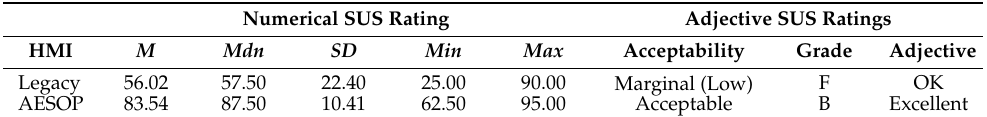
Figure 6. Boxplot of SUS Score Distributions for both HMIs. Table 6. SUS Numerical and Adjective Rating Scales for Both